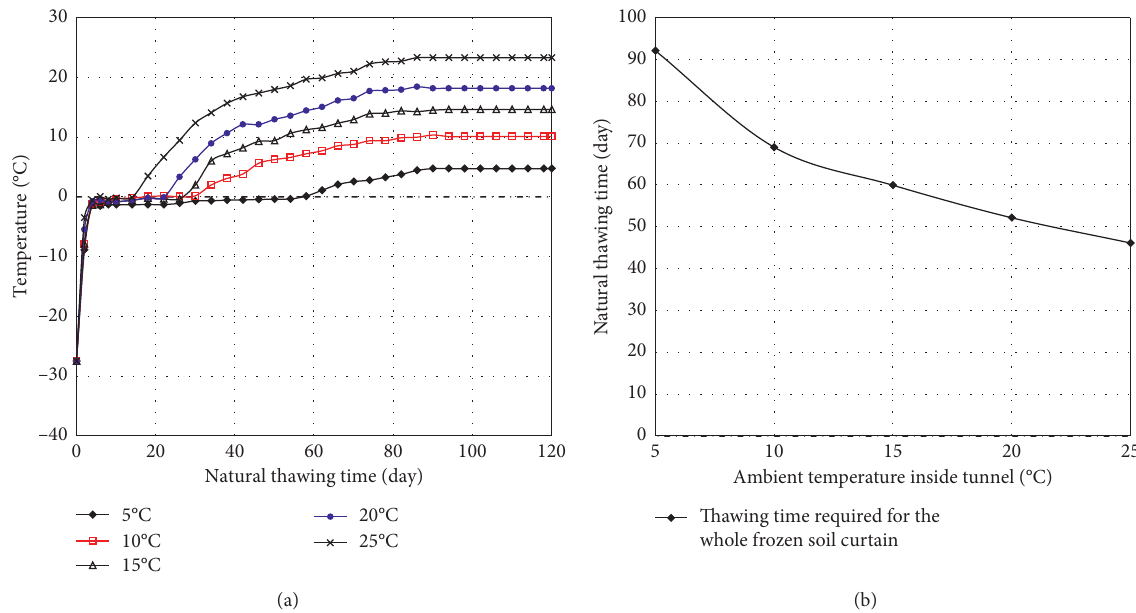
Figure 15: Effects of ambient temperature inside tunnel on the temperature-thawing time response and required thawing time for frozen soil curtain: (a) temperature-thawing time response at X � 3 m (monitor point 2); (b) variation of required thawing time with ambient temperature inside